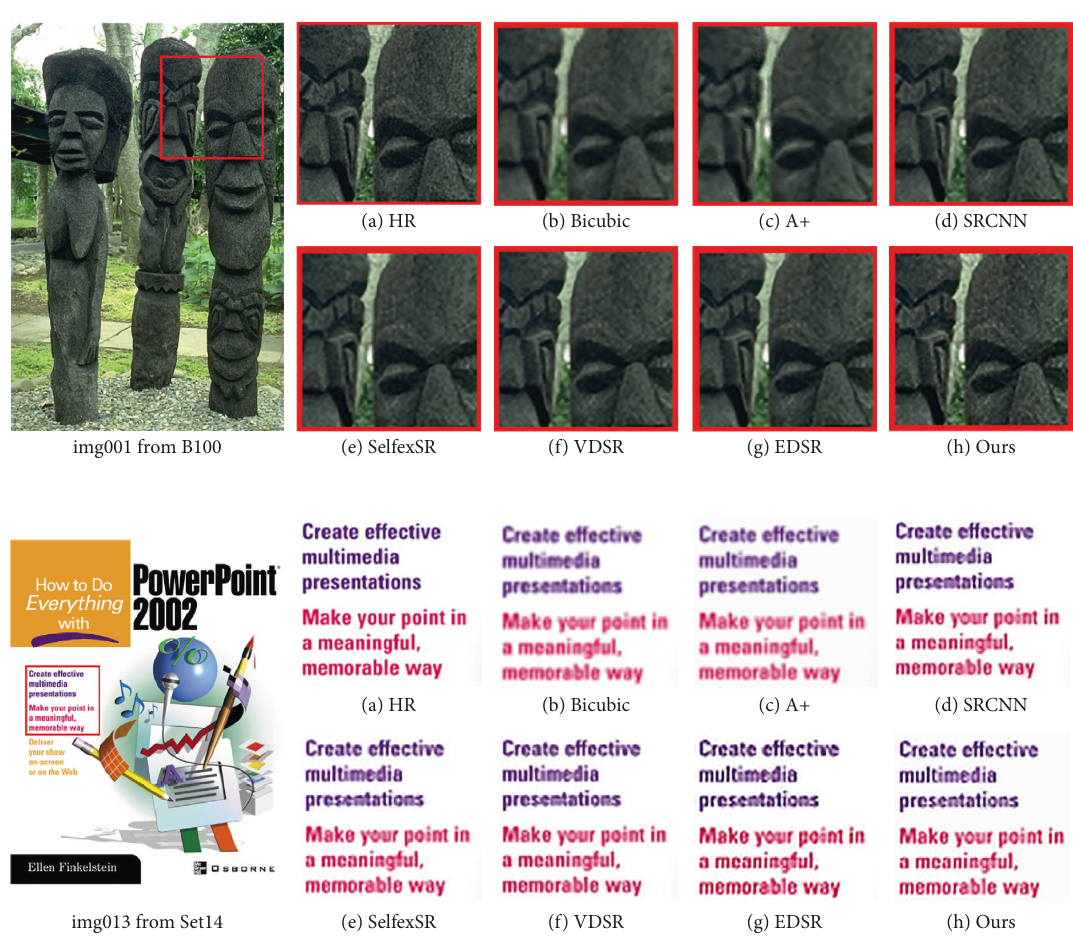
Figure 6: Super-resolution results for scale factor 2. The two pictures show the SR results of the “sculpture” and “ppt,” respectively. Partially enlarged view of the picture in the red box on the right.